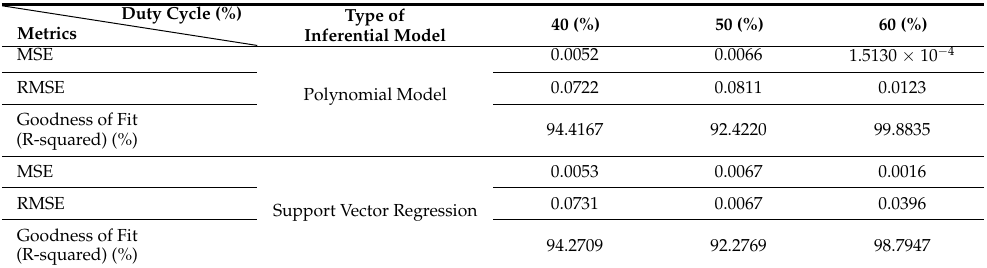
Table 9. Correlation coefficient at different duty cycles.